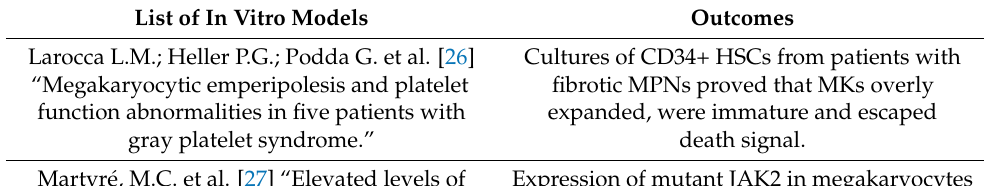
Table 2. Summary of MPNs in vitro models and their main